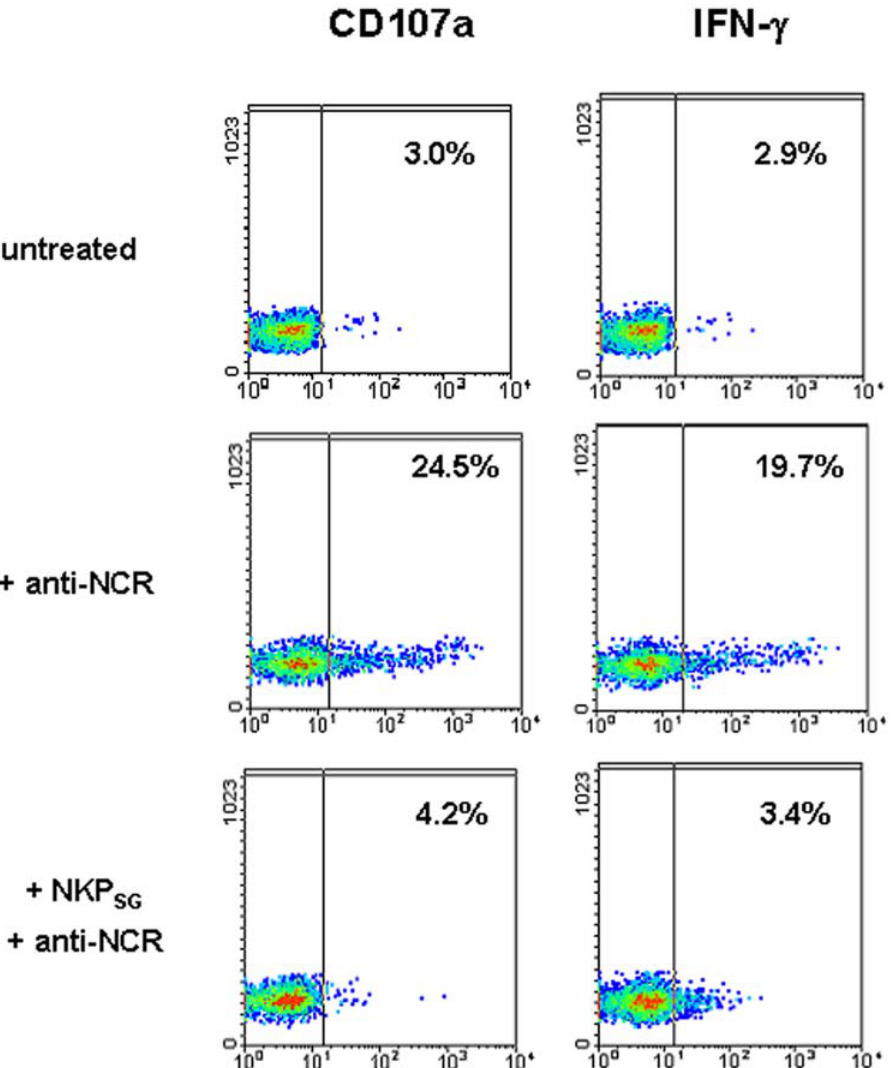
Figure 7. NKP SG cells interfere on the lytic functions of NK cells. Dot plot analysis shows CD107a and IFN c surface expression in conventional IL-2 activated NK cells triggered ( + anti-NCR) or not (untreated) by NCR cross-linking and after 24 hours pre-incubation with NKP SG cells. In order to distinguish co-cultured NK cells from NKP SG cells, these latter were stained with CFSE and excluded from cytometric analysis. The data are representative of three separate